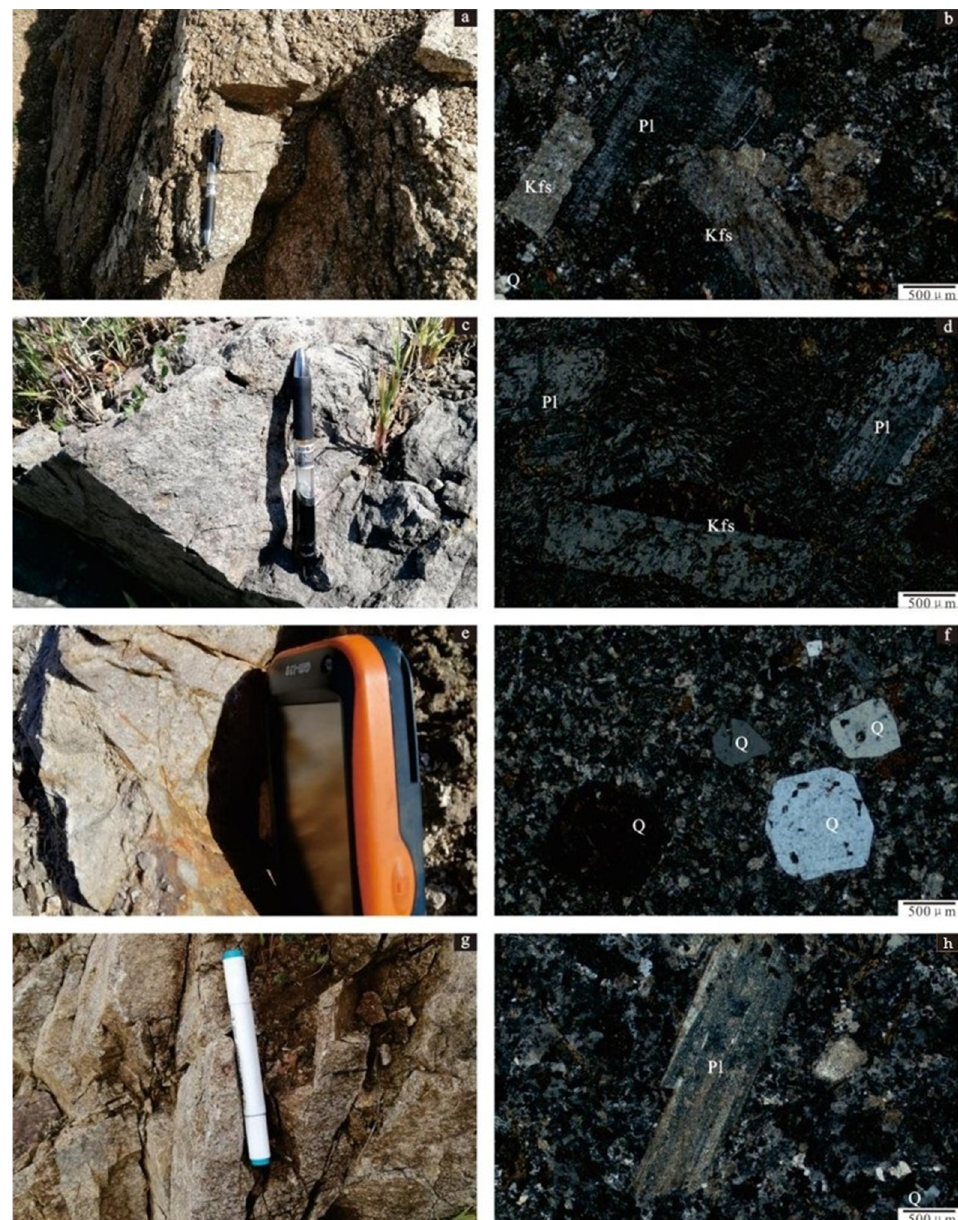
Figure 3. Field photographs and typical microphotographs of the intrusive rocks in the northern part of the Ulanhot area: ( a , b ) quartz monzonite porphyry (Sample DBb04); ( c , d ) monzonite porphyry (Sample DBb08); ( e , f ) quartz porphyry (Sample XLb04); ( g , h ) granite porphyry (Sample SQb13); Q: quartz; Pl: plagioclase; Kfs: K-feldspar.